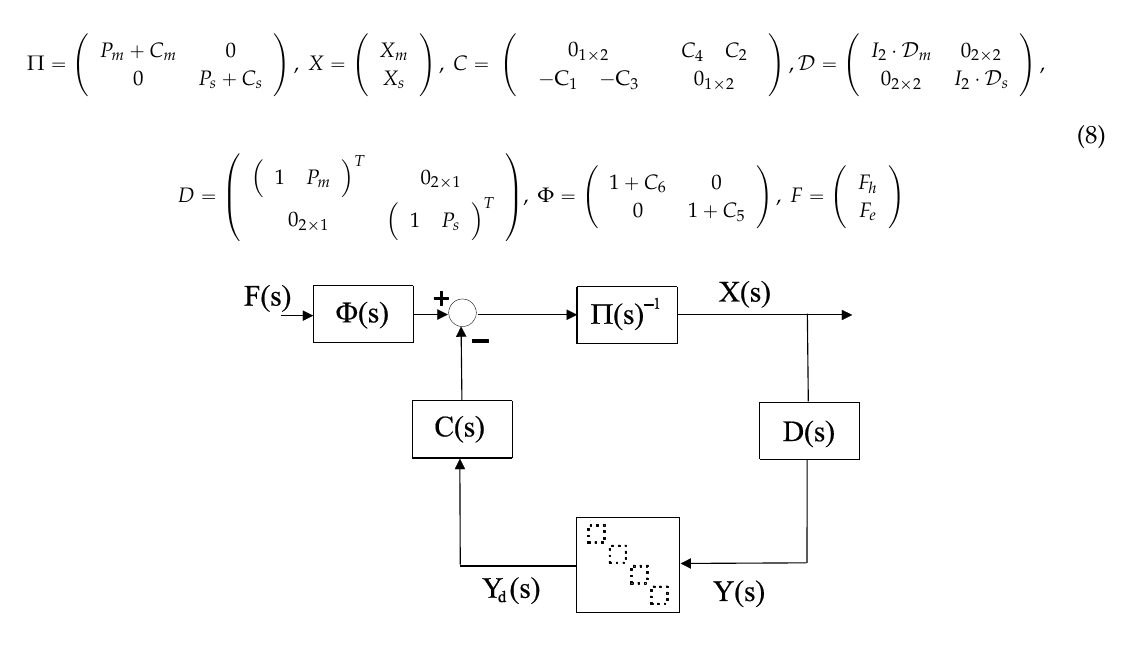
Figure 3. Teleoperation loop.